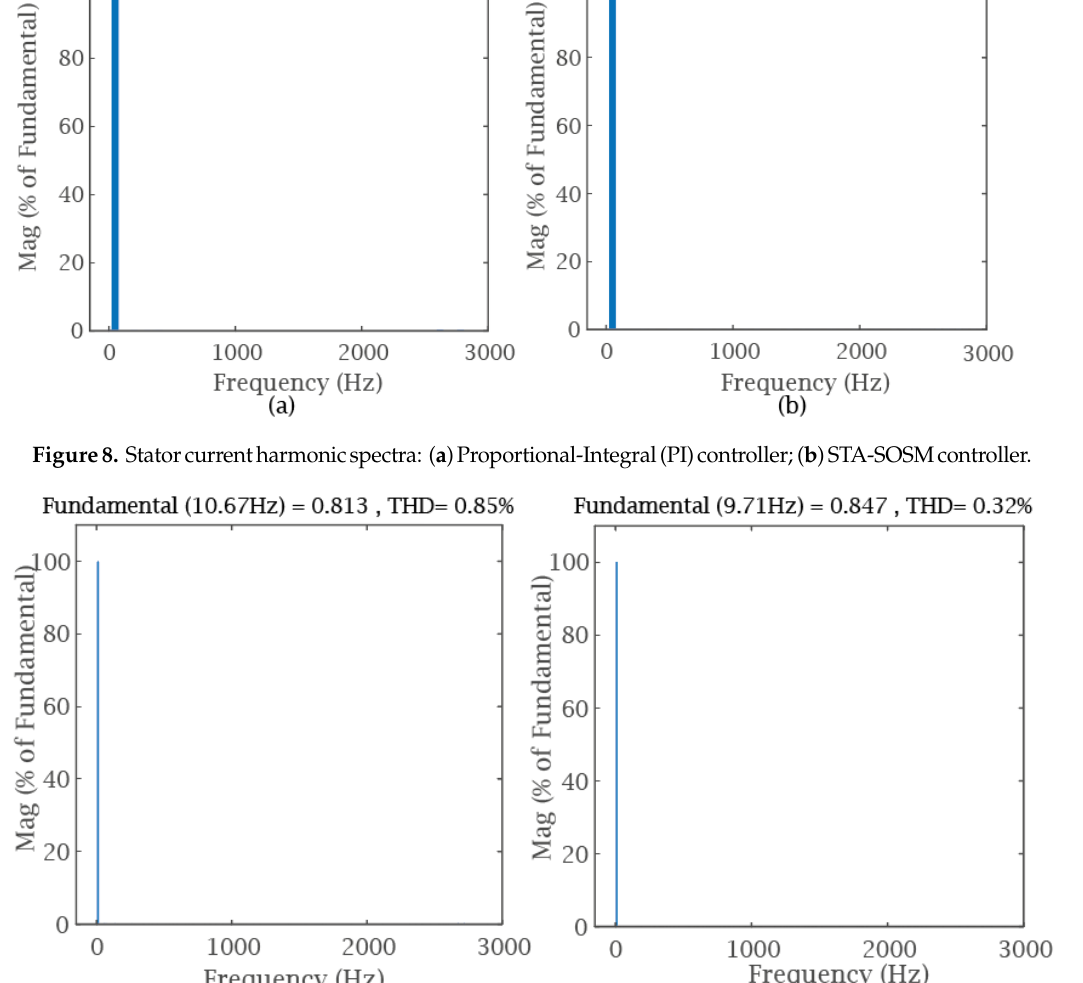
Figure 9. Rotor current harmonic spectra: ( a ) PI controller; ( b ) STA-SOSM controller.